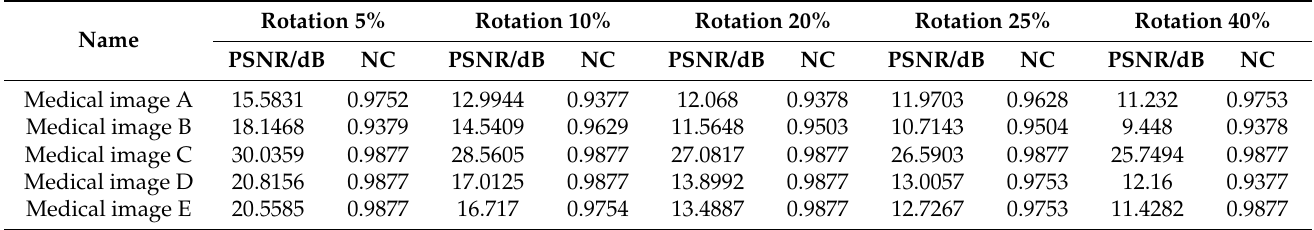
Table 4. The result under clockwise rotation